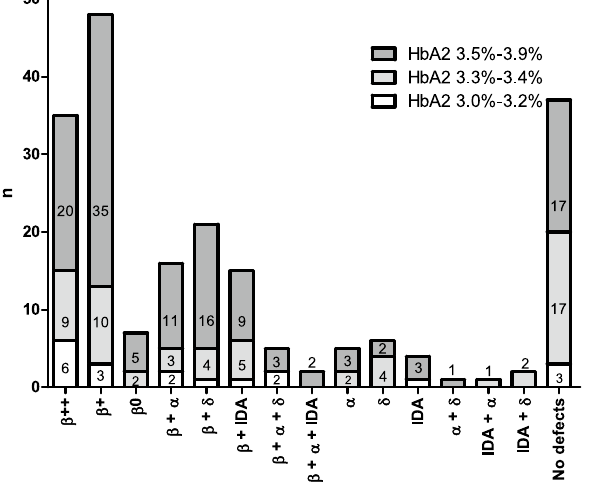
Figure 2. Distribution of individuals based on HbA 2 levels and defects identified . Number of study subjects showing different defects grouped according to their HbA 2 levels. Blank boxes indicate n = 1.